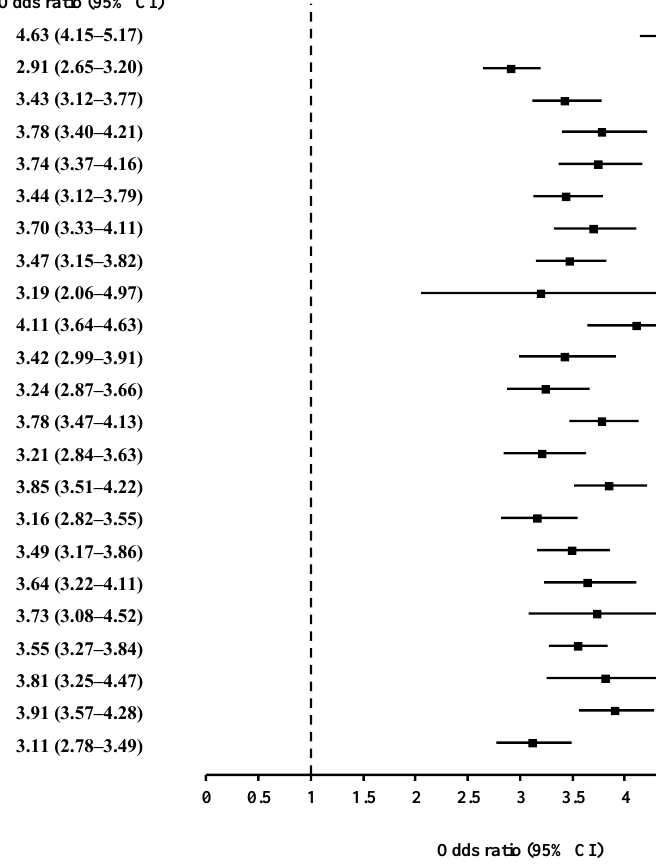
Figure 2. Subgroup analyses of current PPI users for BPPV according to age, sex, income, region of residence, obesity, smoking status, alcohol consumption, total cholesterol, blood pressure, and fasting blood glucose visualized with forest plot. Abbreviations: BPPV, benign paroxysmal positional vertigo; DBP, diastolic blood pressure; PPI, proton pump inhibitor; SBP, systolic blood pressure.